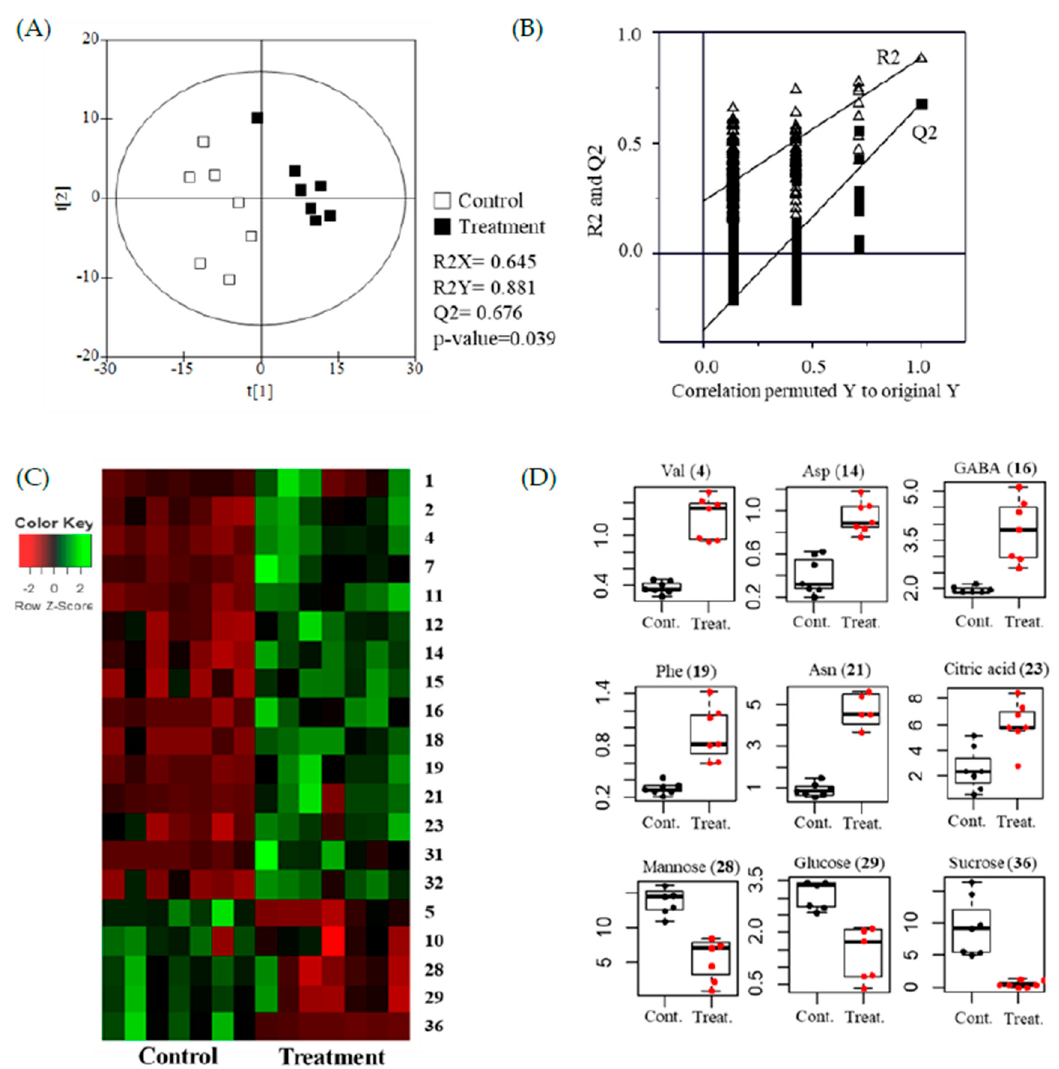
Figure 3. Metabolomic analysis of soybean leaves using gas chromatography–mass spectrometry (GC-MS). ( A ) Partial variance discriminant analysis (PLS-DA) plots of untreated (control) and ethylene treated (treatment). ( B ) Performance of the permutation tests validated from the PLS-DA model. ( C ) Heatmap for the 20 metabolites ( p < 0.05) between control and treatment. ( D ) Boxplots of representative